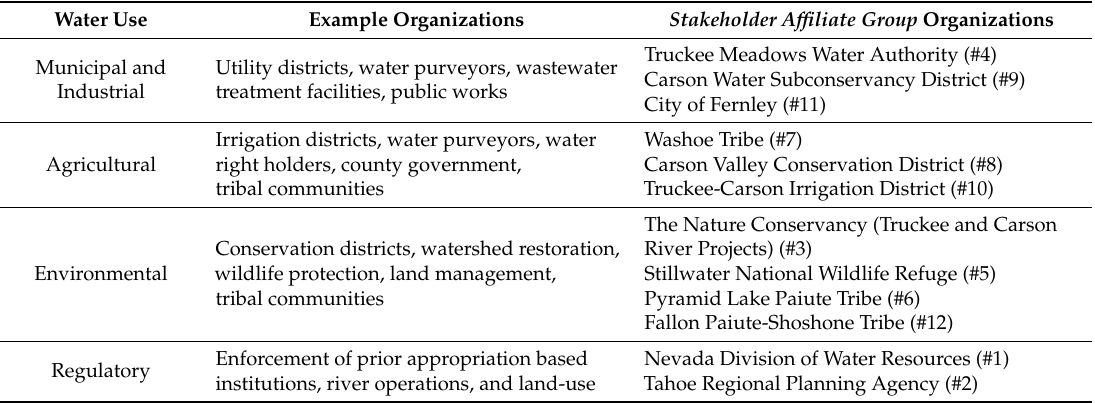
Table 2 defines these water uses, provides examples of water management organizations per use, and lists the corresponding Stakeholder Affiliate Group representative organization for each use. Table 2. Water use, example organizations, and Stakeholder Affiliate Group organization s . The number in parentheses corresponds to the location of the organization as indicated in Figure